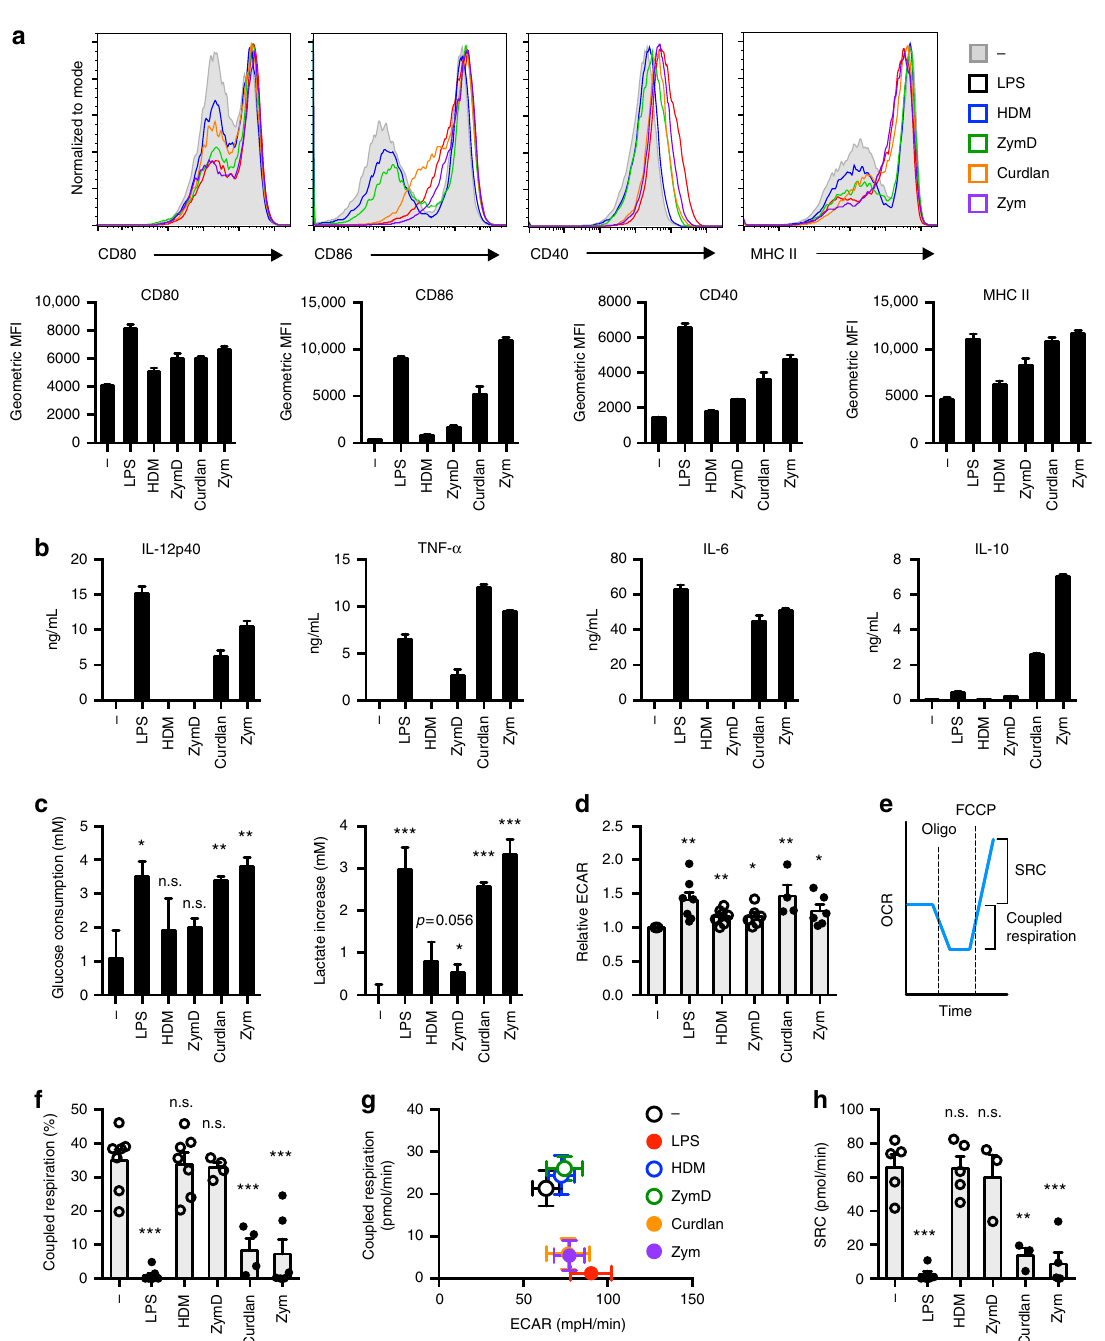
Fig. 1 Bioenergetic pro fi les of differentially activated DCs. a , b Activation marker expression (CD80, CD86, CD40, and MHC II) and cytokine production (IL-12p40, TNF- α , IL-6, and IL-10) were measured following 18 h activation with indicated activators. c Glucose consumption (left) and lactate increase compared to the unstimulated condition (right) were measured 18 h following stimulation. d , f – h ECAR and OCR were measured using a Seahorse Bioanalyzer following an 18 h stimulation. e Coupled respiration is represented by the decrease in OCR from baseline after oligomycin treatment, and is therefore the OCR attributed to ATP production. Spare respiratory capacity (SRC) is represented by the increase in OCR from baseline after FCCP treatment. f Coupled respiration as a percentage of total respiration. g Mean coupled respiration versus mean ECAR. h SRC. Data shown in a – c are from one experiment representative of at least three independent experiments (mean and s.d. of triplicates ( a , c ) or duplicates ( b )). Data shown in d , f – h are from three to seven experiments (depending on condition) (mean and s.e.m.). LPS: lipopolysaccharide, HDM: house dust mite, ZymD: zymosan depleted of TLR ligands, Zym: zymosan, ECAR: extracellular acidi fi cation rate, OCR: oxygen consumption rate. Data were analyzed using t -test, comparing each condition relative to the control. *** p < 0.001, ** p < 0.01, * p <